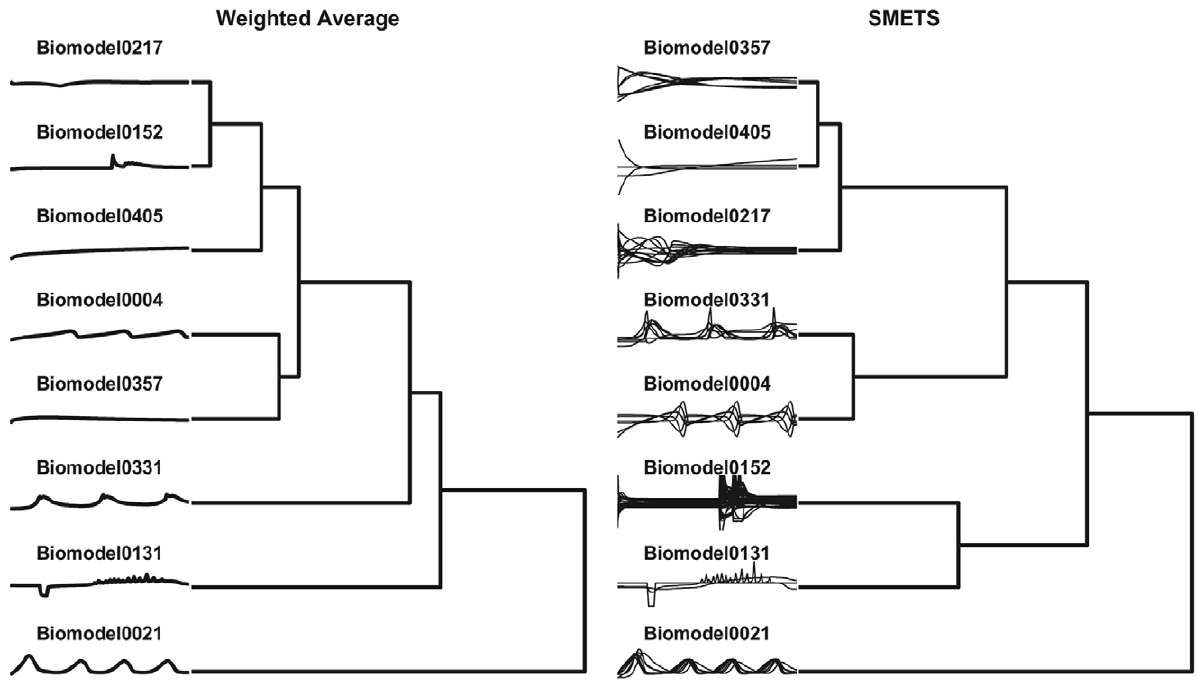
Figure 5. Hierarchical clustering of eight systems biology models. Models were obtained from the BioModels database [28] using average versus SMETS. The dendrogram reveals the relative distances between each entity. The time series considered by each method are represented to the left.